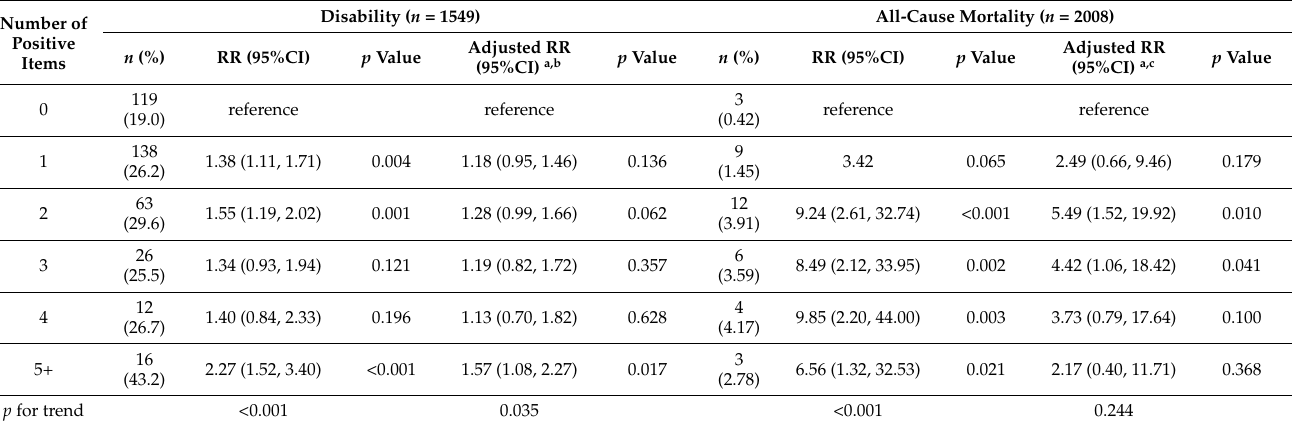
Table 5. The results of the CFSS-10 predicting one-year disability and all-cause mortality (sample